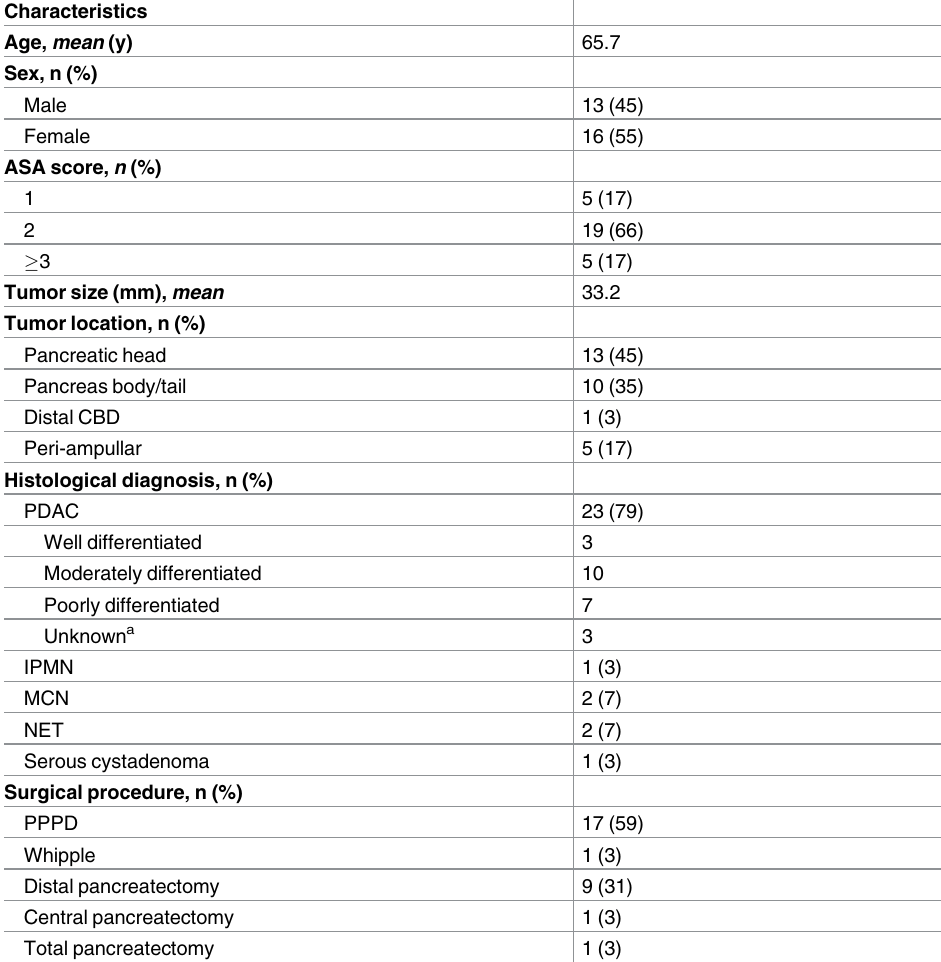
Table 2. Patient and tumor characteristics.